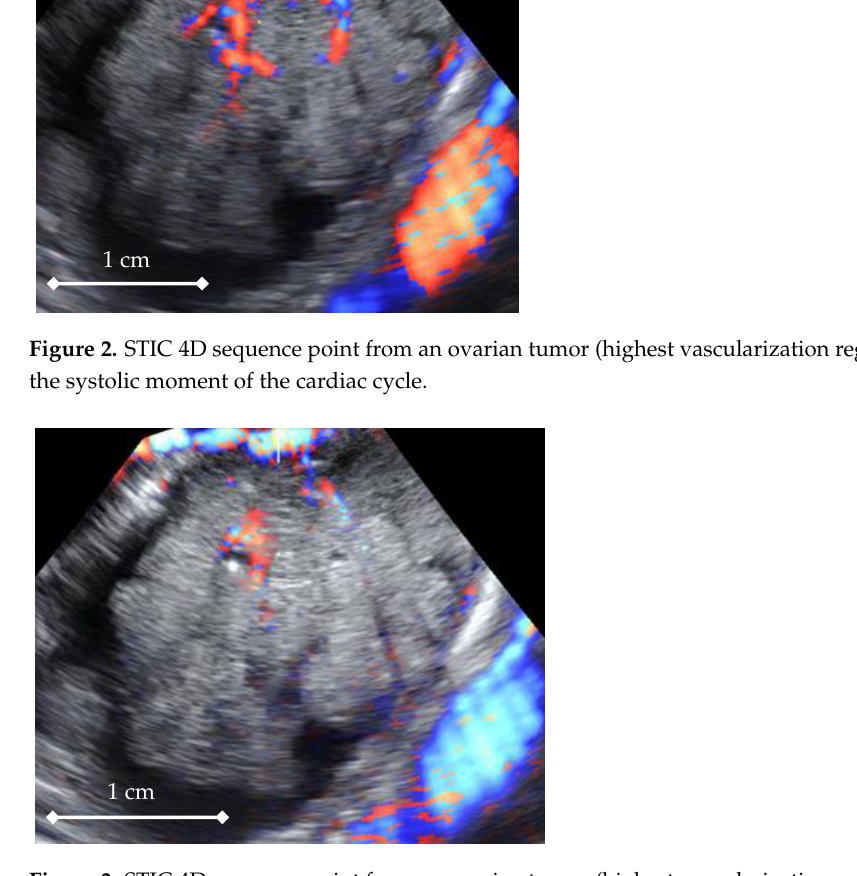
Figure 3. STIC 4D sequence point from an ovarian tumor (highest vascularization region), depicting the diastolic moment of the cardiac cycle.